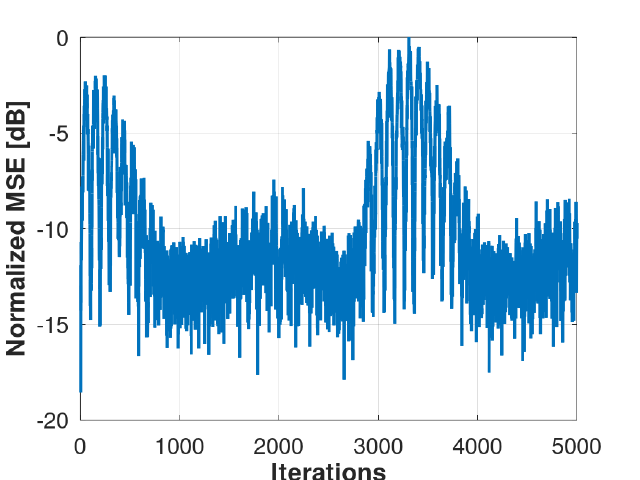
Figure 14. Normalized-MSE results produced by the FsinX-LMS algorithm for 30 runs of a Monte Carlo simulation.